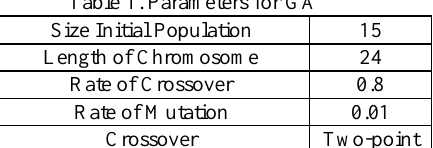
Table 1. Parameters for